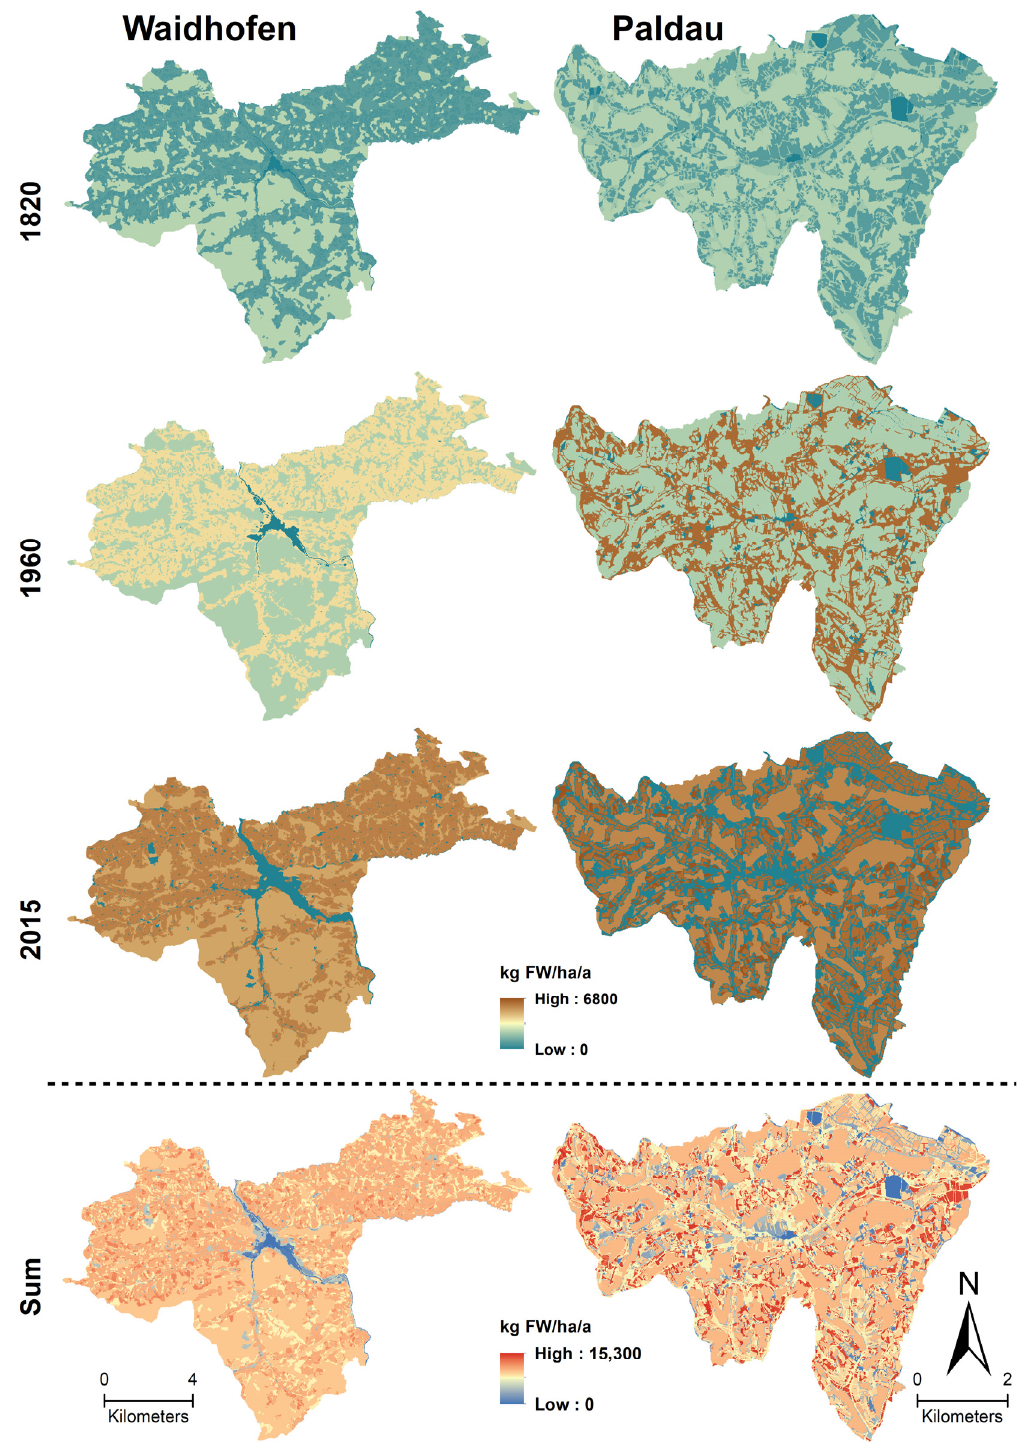
Figure A1. Biomass extraction [kg FW/ha/a] as an indicator of historical land use intensity of study Table A3. Summary of the landslide inventory data.